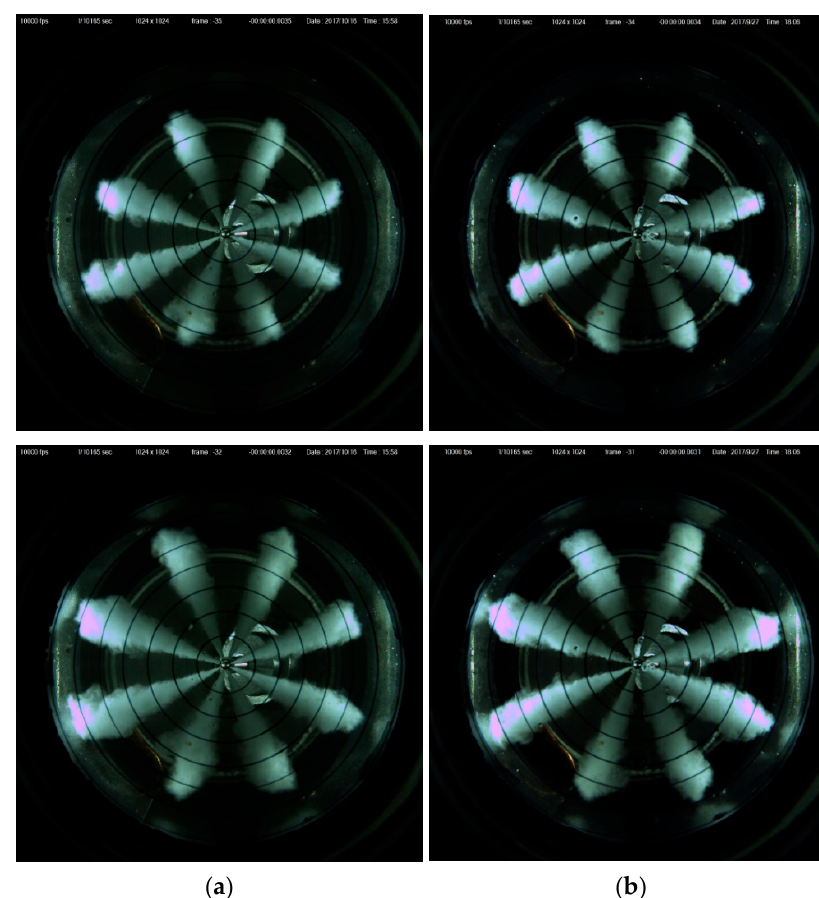
Figure A3. Development of fuel sprays in a constant volume chamber with nozzle 1 ( a ) and nozzle 2 ( b ) with a rail pressure of 165 MPa.